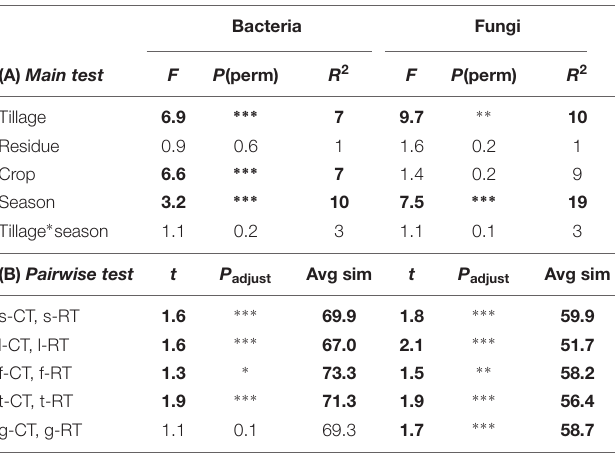
TABLE 2 | Effects of tillage regime, crop residue management, crop, and growing season on bacterial and fungal β -diversity. Bacteria